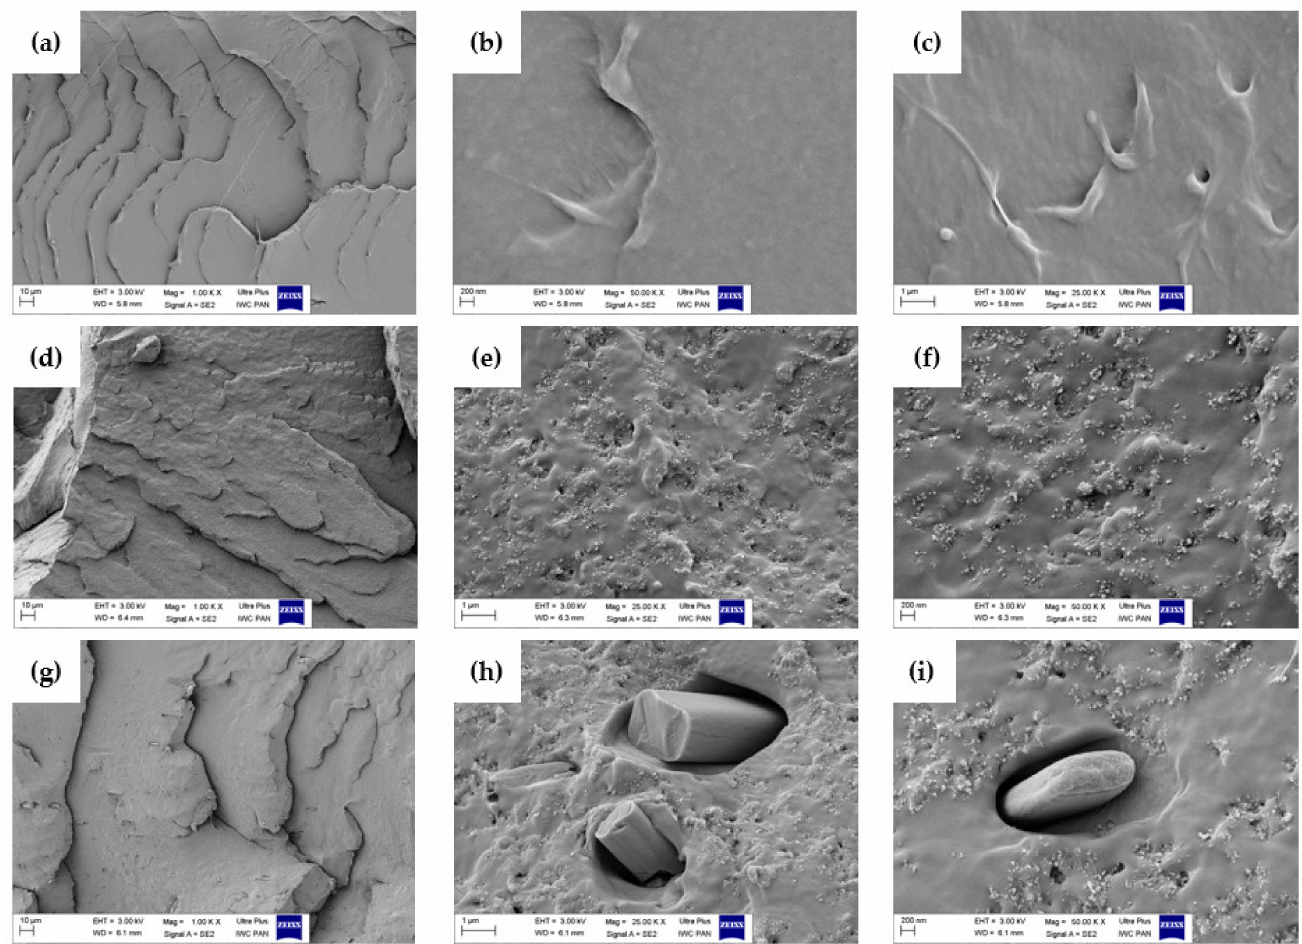
Figure 9. Morphology of ( a – c ) pure Topas, ( d – f ) Topas-silica, ( g – i ) Topas-silica-hesperidin composites obtained by the scanning electron microscopy (SEM) with 1000 × , 25,000 × and 50,000 ×